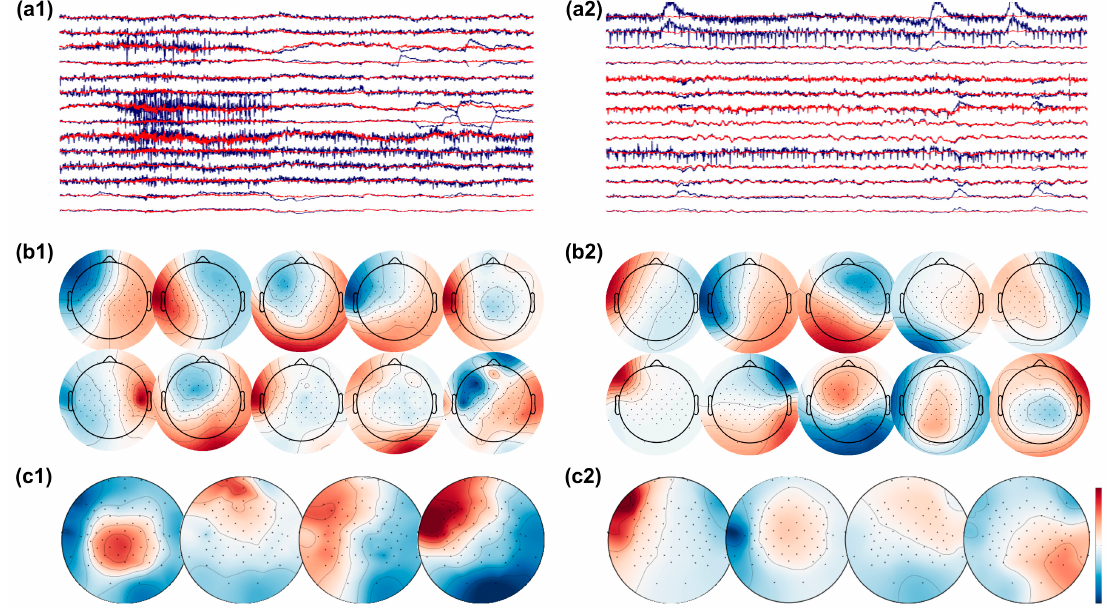
Figure 12. EEG signals before (raw EEG, blue) and after (clean EEG, red) artifact removal with ICA from patient 1 ( a1 ) and patient 2 ( a2 ). The top 10 brain ICs are shown in ( b1 , b2 ), and the top 4 spatial pattern projections after applying the CSP algorithm are shown in ( c1 , c2 ). The topographies show successful removal of artifacts in patient 1, while artifacts are present in the topographies of patient